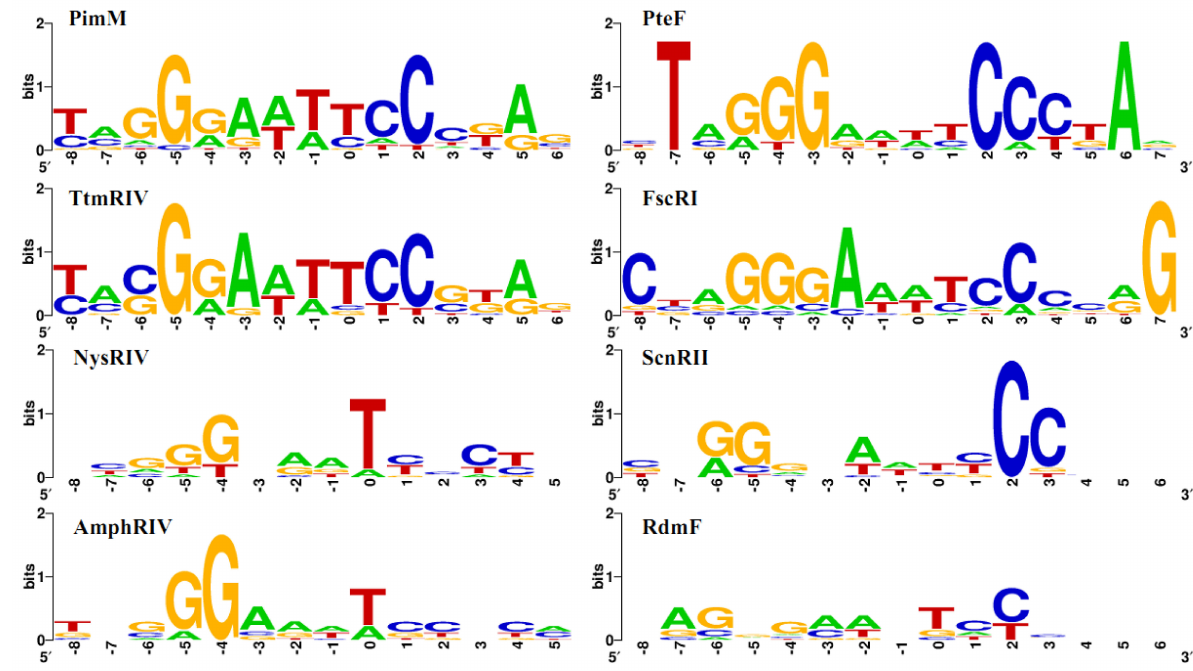
Figure 7. Prediction of binding sites of the PAS-LuxR family